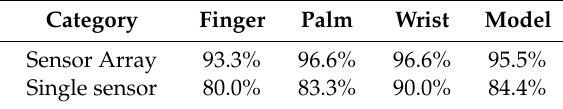
Table 2. The recognition accuracy in di ff erent